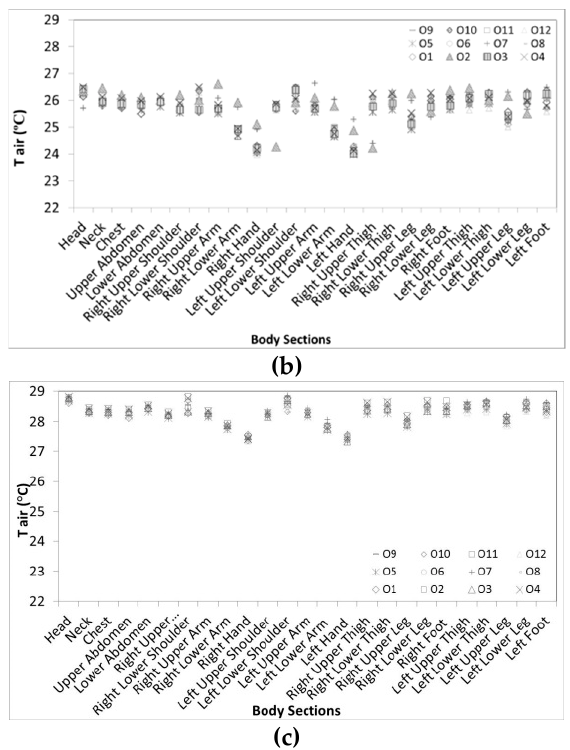
Figure 17. Mean air temperature value around the 25 human body sections of 12 occupants, for an inlet air temperature of ( a ) 20 °C and ( b ) 24 °C.